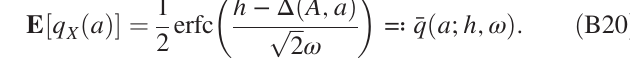
tions Eq. (B15) and (B16) for v ð a Þ and Λ ð a Þ , and assuming Λ ð 0 Þ ¼ 0 — when a 10 , A ¼ 90 , σ ¼ 5 , ϵ ¼ 0 . 1 at time t ¼ 0 ¼ A= 2 ¼ 45 (chosen so that oldest speaker at x ¼ 0 has just switched variable). For these parameter values ¯ a ¼ 35 . 23 . Ver- tical dashed line is drawn at location of youngest adopter of new variable (giving width of transition region). Open circles give frequency values using an age distribution discretized into two- year bins, computed by numerically evolving the full model.